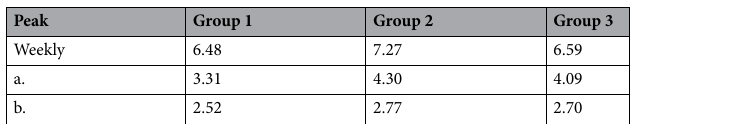
Table 1. Spectral peaks for the three country groups in units of days. The peaks in the second and third rows have been arbitrarily labelled as peak (a) and (b). The peak values have been taken by manual location and, of course, are subject to